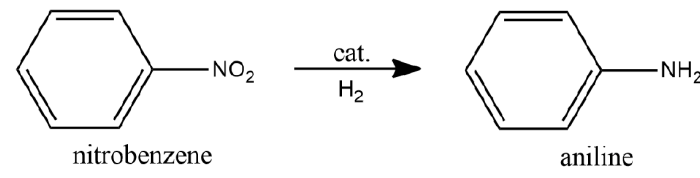
Figure 1. General reaction of nitrobenzene hydrogenation to